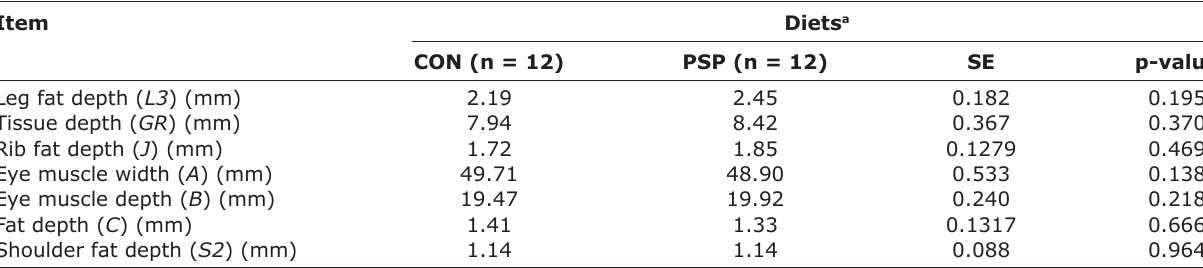
Table-4: Effects of feeding PSP on carcass leaner dimensions of Awassi